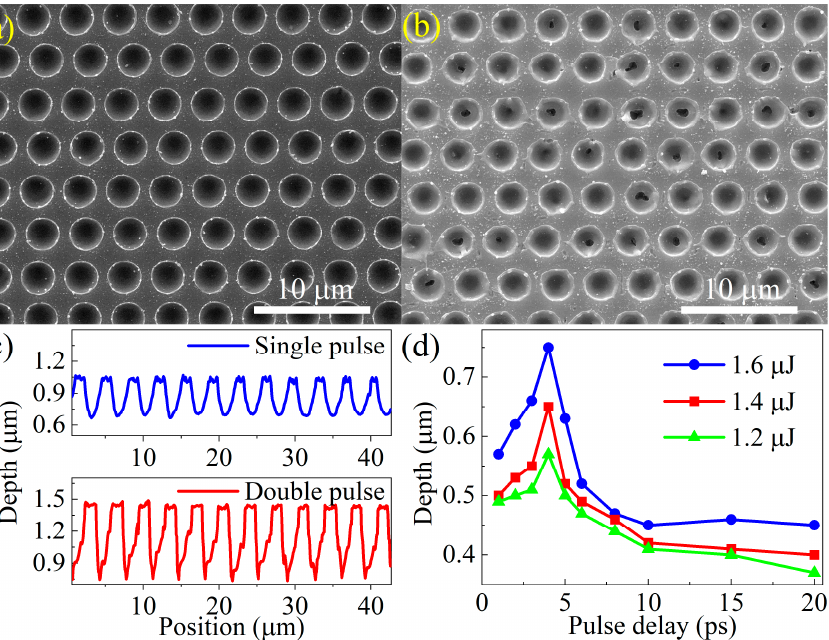
Figure 2. SEM images of the SQA fabricated by single-pulse ( a ) and double-pulse ( b ) femtosecond laser, and corresponding cross section profiles ( c ). ( d ) Depth of the SQA as a function of pulse delay with total pulse energy of 1.6 µJ, 1.4 µJ, and 1.2 µJ.